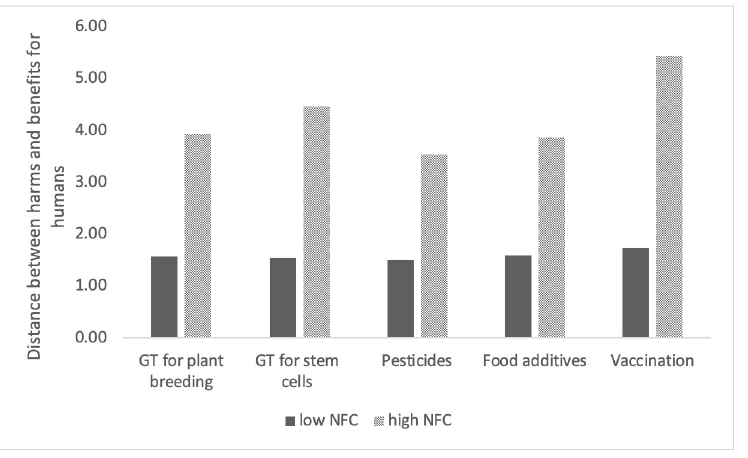
Fig 2. Distance between harms and benefits for humans for two groups: Low and high in NFC.